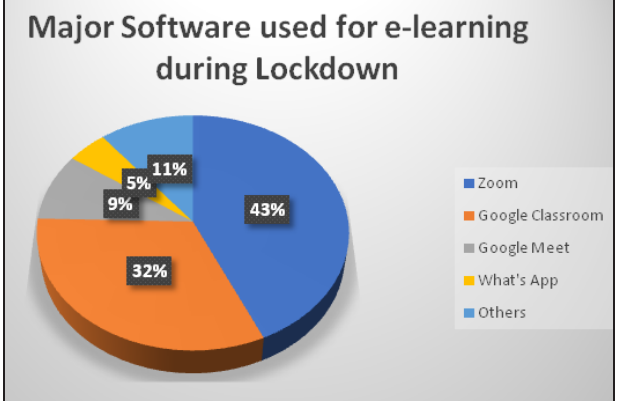
Figure-II: The major barriers faced by the students during online learning sessions at residence.